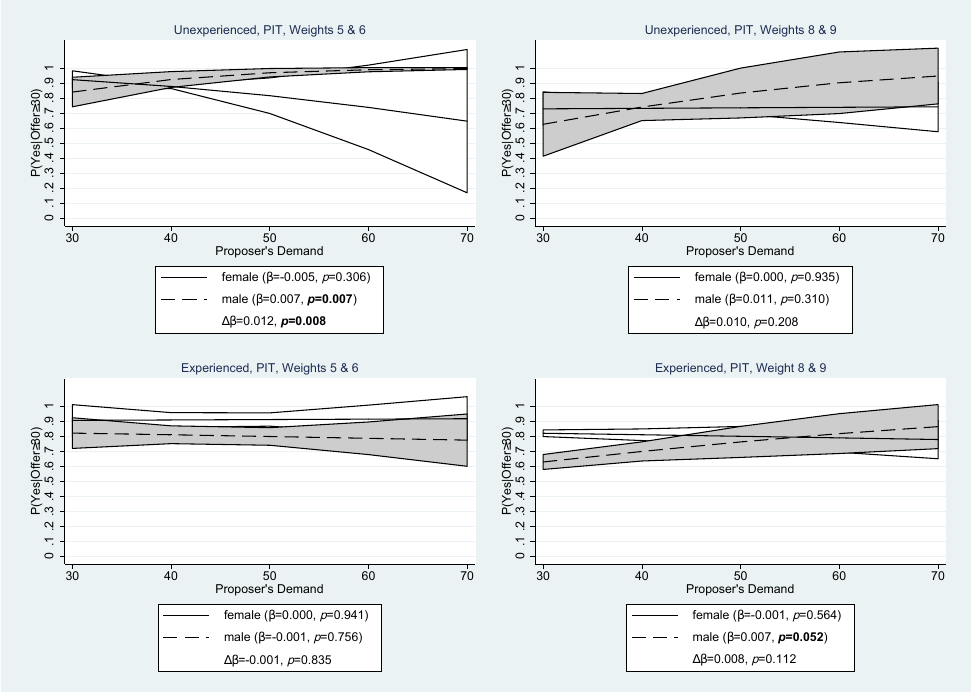
Figure A3. Responder Voting Behavior: Proposer’s Demand in P IT by Nominal Voting Weight. The graphs show the responder’s average probability to vote “yes” on an offer ≥ 30 tokens, given the proposer’s demand in tokens by experience, nominal voting weight, and gender. β and ∆ β are the marginal effect of the proposer’s demand and the differential slope of Gender { 1 = male } estimated by a random effects probit panel regression. p is the significance level. Shaded areas represent 90% confidence intervals around the